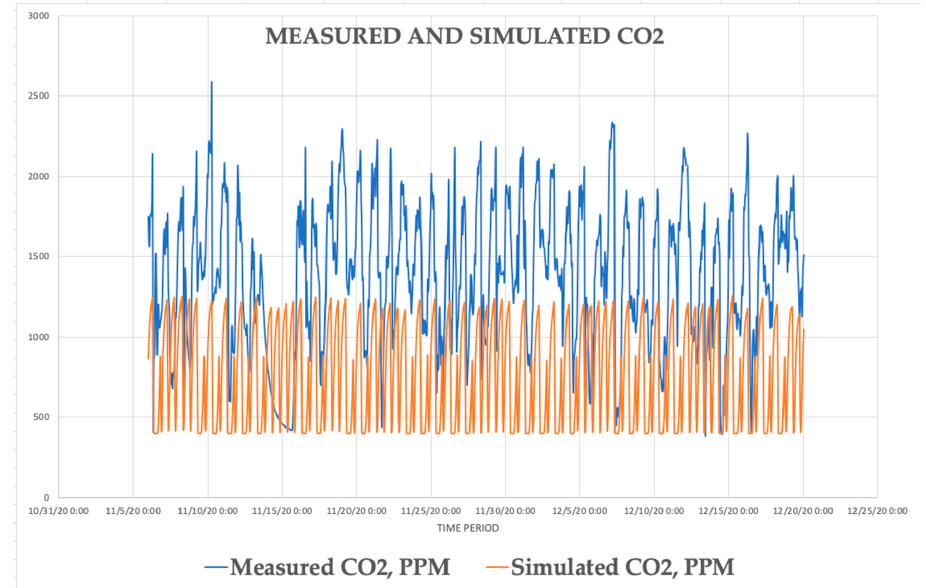
Figure 5. Measured and simulated CO 2 .